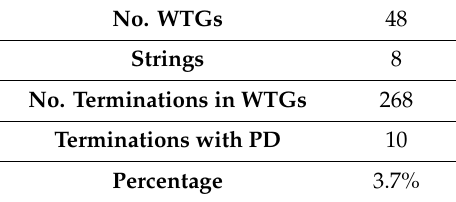
Table 2. Results of DAC condition assessment on an o ff shore wind farm (OSWF).